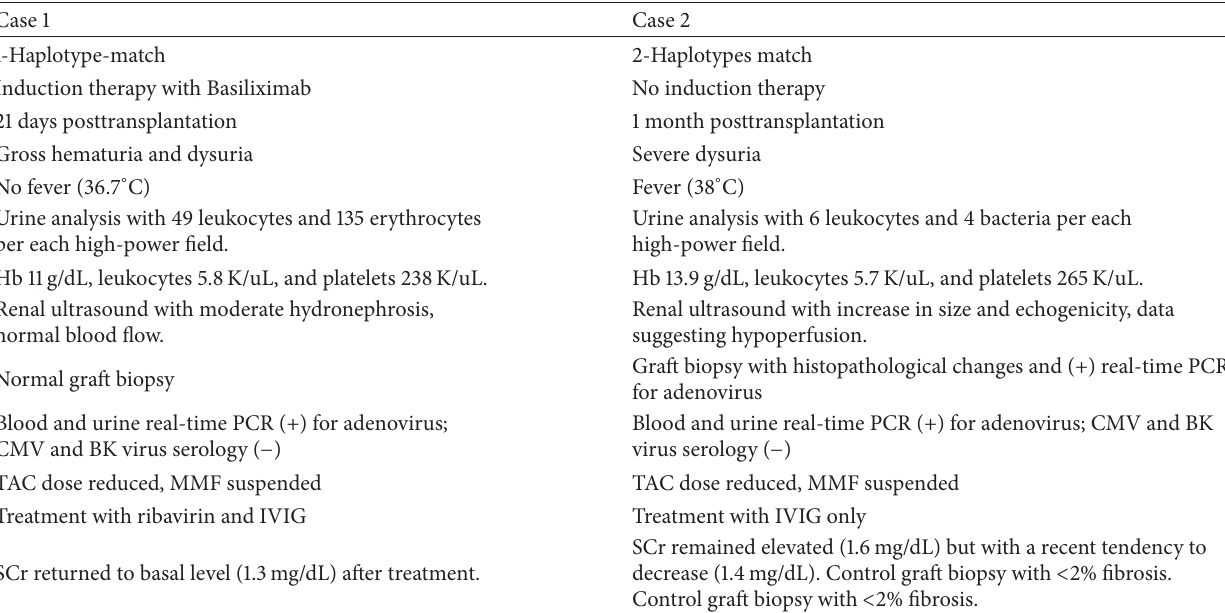
Table 1: Clinical manifestations and treatment